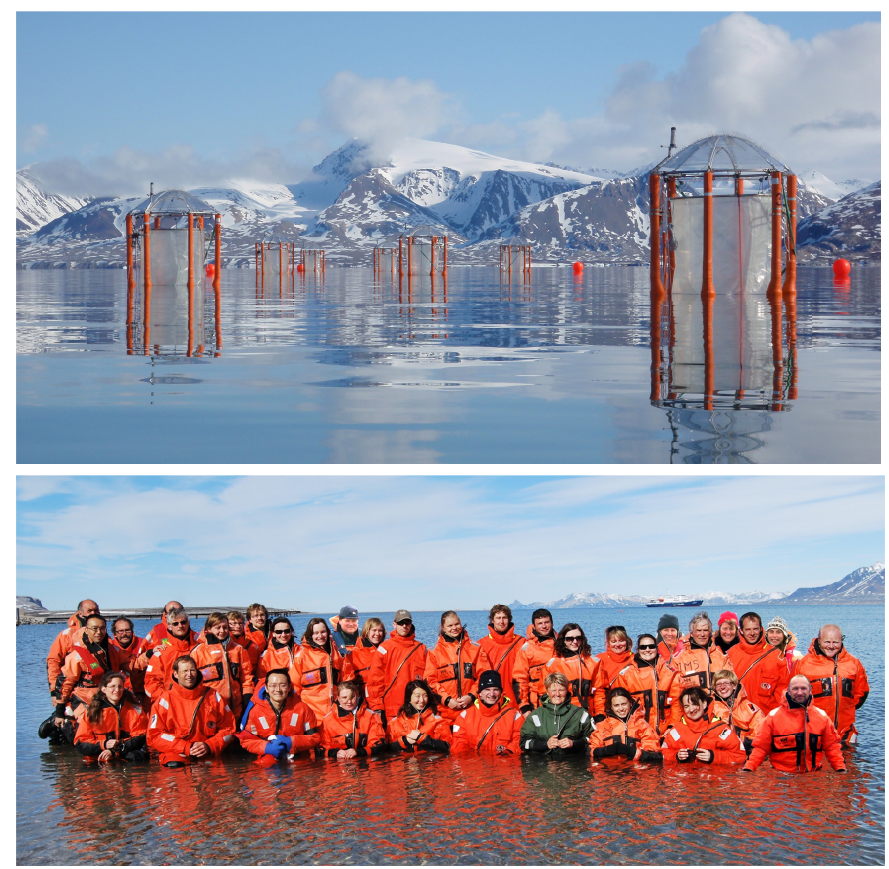
Fig. 1. Top – KOSMOS mesocosms deployed in Kongsfjord, Svalbard. Bottom – participants of the mesocosm study (from left to right - front row: Eva Leu, Ulf Riebesell, Rui Zhang, Anna de Kluijver, Chiaki Motegi, Michael Meyerh¨ofer, Signe Koch-Klavsen, Sarah Romac, Andrea Ludwig, Corinna Borchard, Richard Bellerby; back row: John Stephens, Tsuneo Tanaka, Kai Schulz, Jan Czerny, Nicole H¨andel,